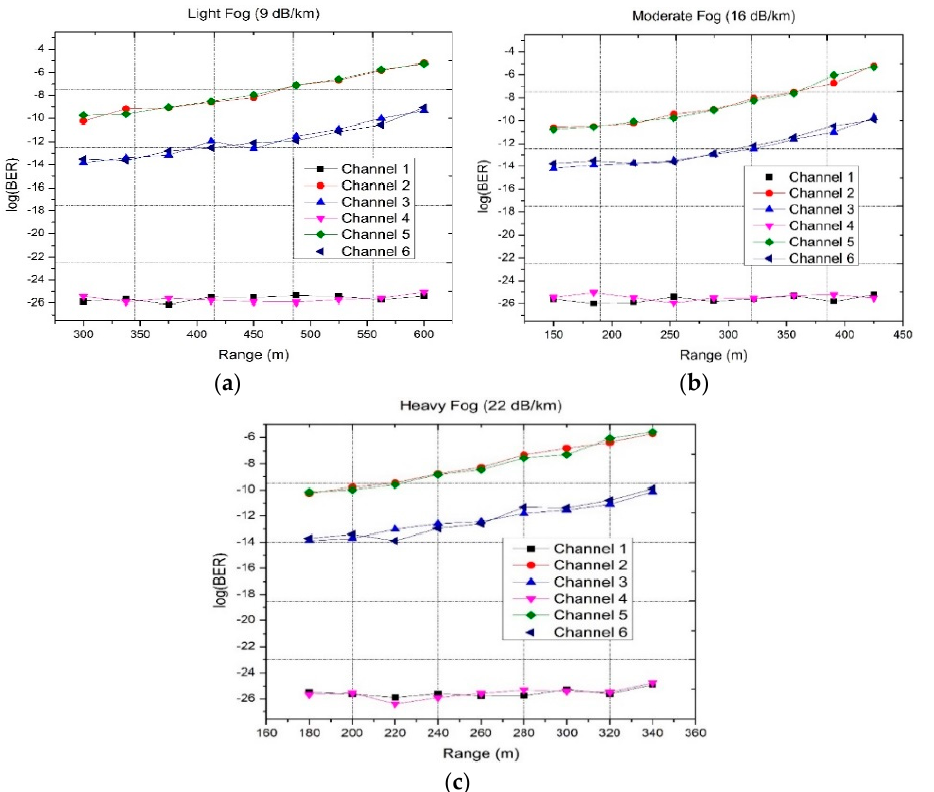
Figure 6. Log (BER) against FSO link for OAM/OCDMA-FSO system under ( a ) LF, ( b ) MF, and ( c ) HF.